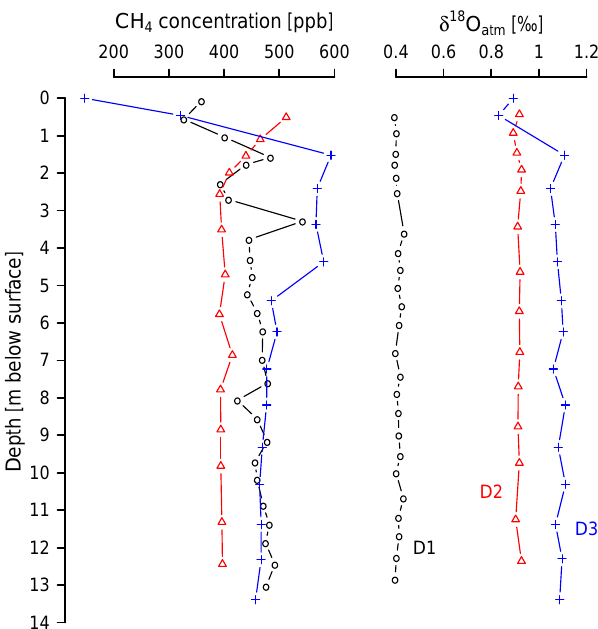
Figure 2. Depth profiles of methane and δ 18 O atm at the sampling sites D1 ( ◦ ), D2 ( (cid:52) ), and D3 ( + ). The analytical uncertainty based on replicate analyses is smaller than the size of the symbols in the plot for both methane (lab analyses, 1 σ of 7ppb) and δ 18 O atm (1 σ of